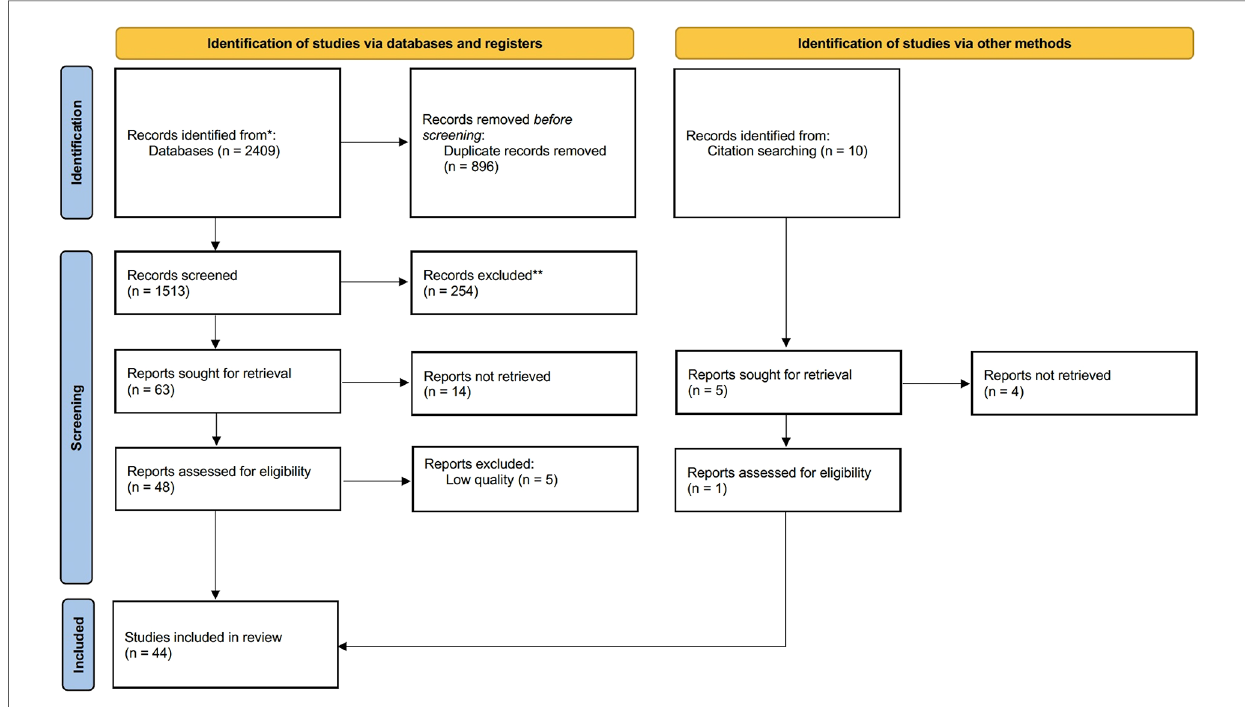
FIGURE 1 Flowchart of literature